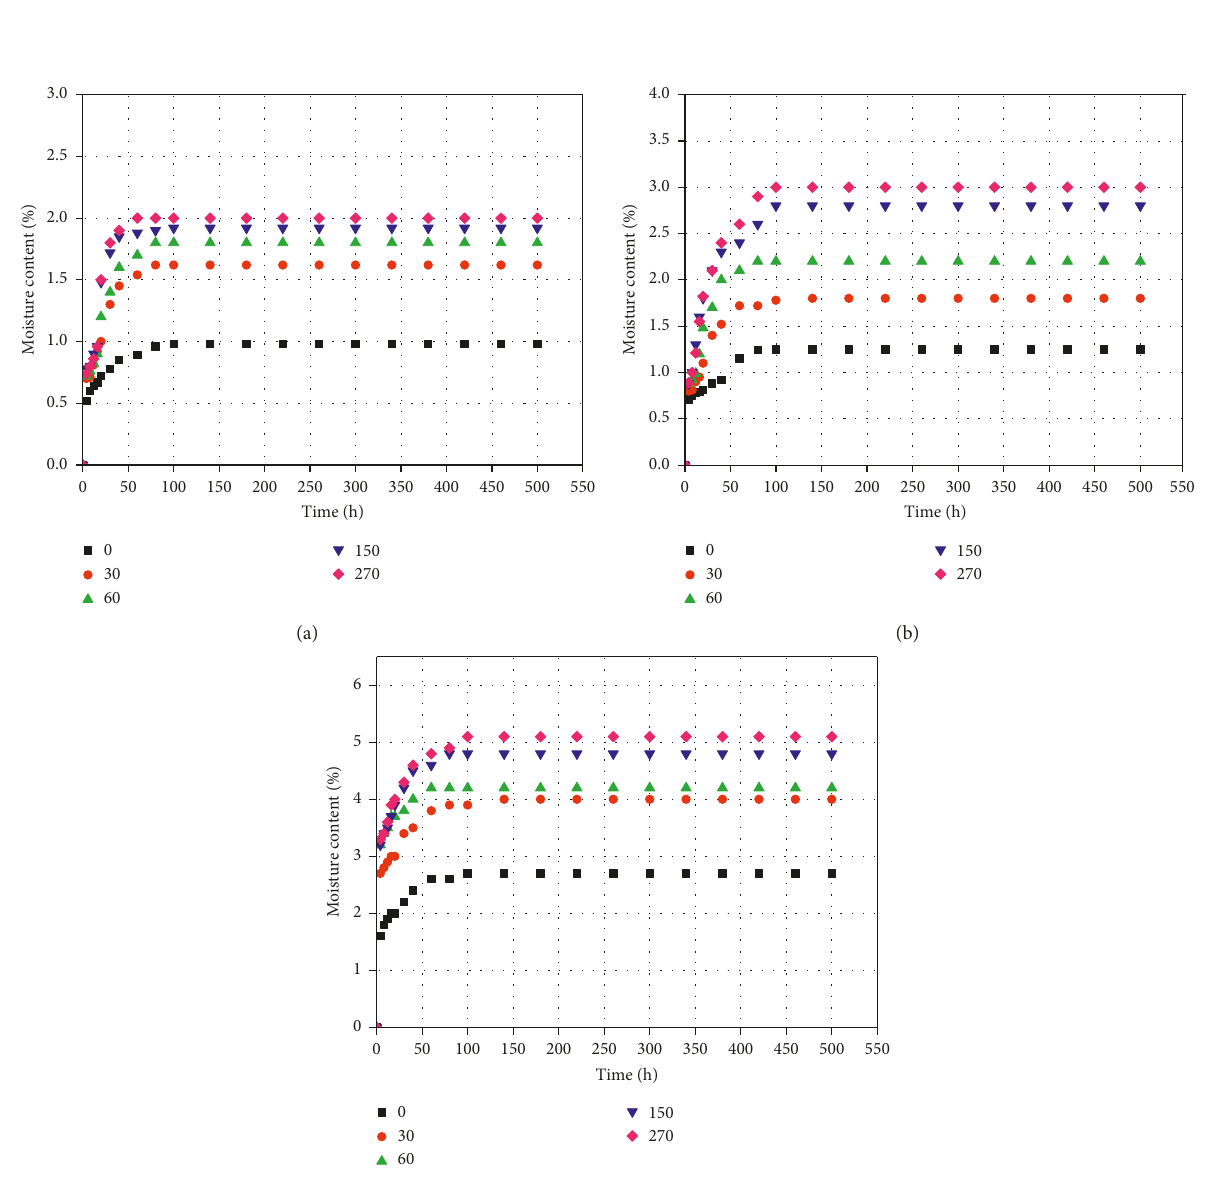
Figure 1: Moisture absorption curve at the temperature of 20 ° C at (a) RH 40%, (b) RH 60%, and (c) RH